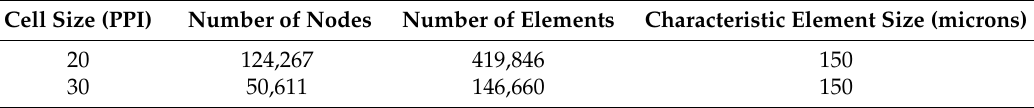
Table 4. Characteristics of the reference volume meshes for the two foam